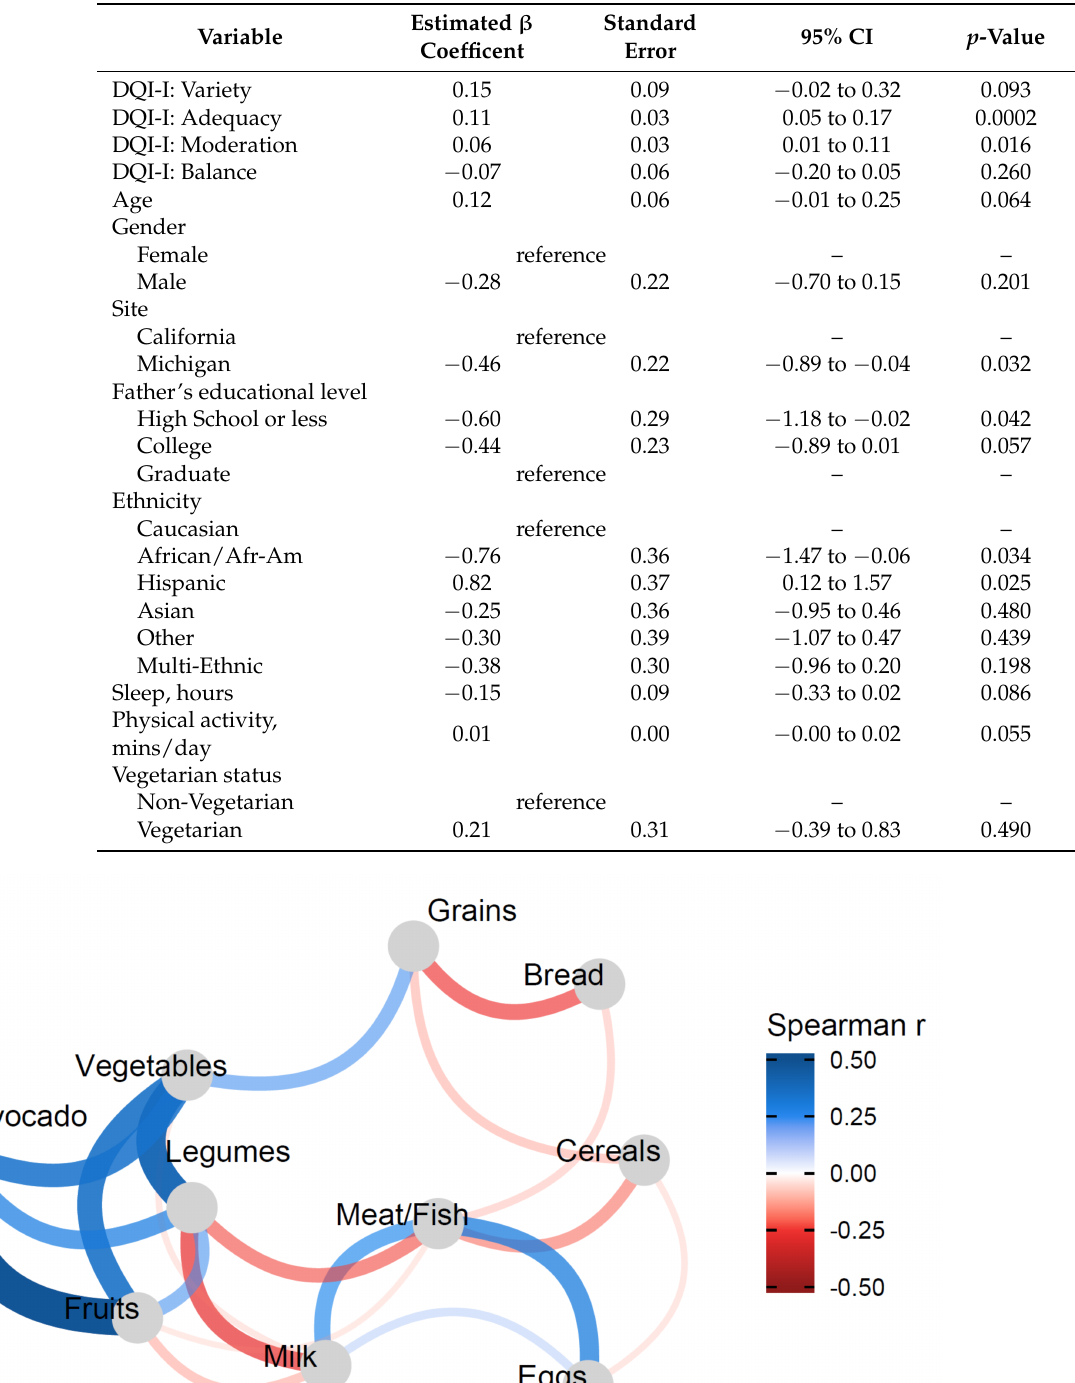
Table 6. Demographic and diet quality determinants of avocado intake.